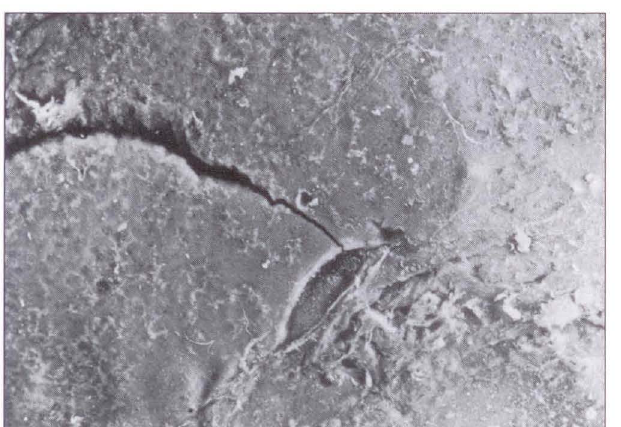
Figure 4) Scanning electron micrograph clearly showing a spe cially prepared antibody-stabilized mucous layer covering the uroepitheliLLn1 as a continuous blanket. This mucus or glycosaminoglycan layer acts as a barrier to bacterial ad herence. Mechanical or microbial irritation dismpts this protec tive layer. allowing bacterial adherence and SLLbsequent symptomatic cystitis. The bladder mucosa can be observed through a crescent-shaped defect in the mucus layer. (x-+2)